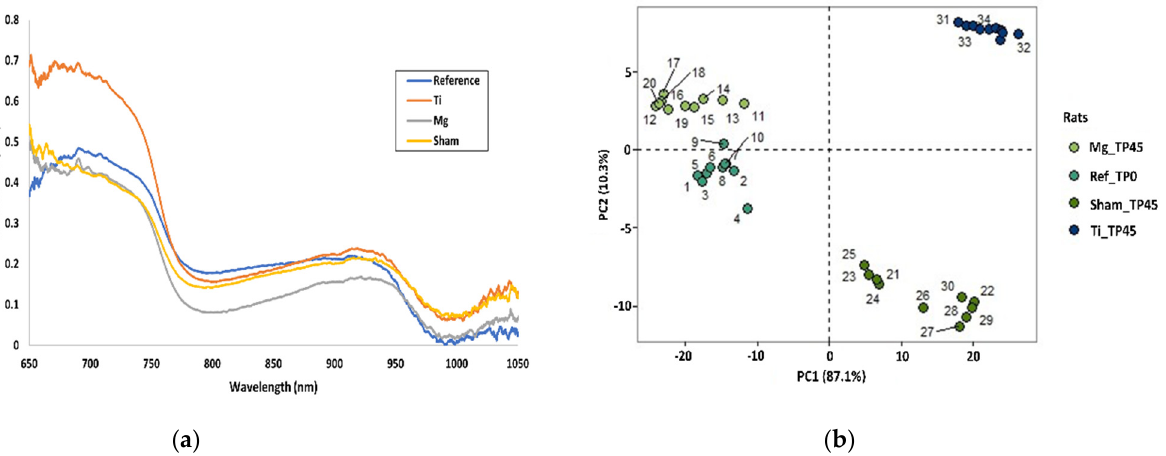
Figure 8. ( a ) Preliminary results in terms of absorption directly from the spectrometer, and ( b ) PCA score plot of all rats pre-operatively at Day 0 and post-operatively at Day 45; for reference, Mg-, Ti-, and sham-implanted rats are shown.